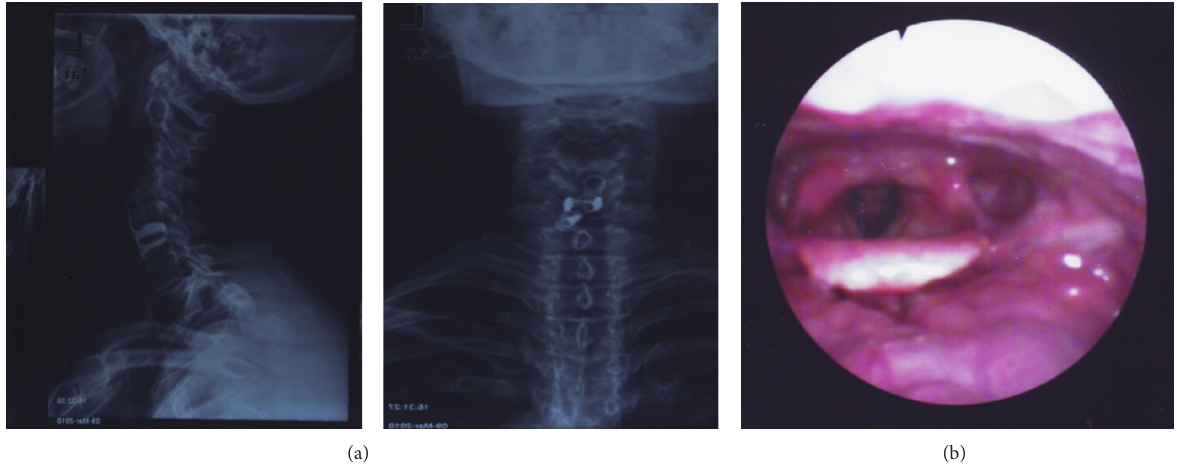
Figure 4: Radiographic and endoscopic controls after 3